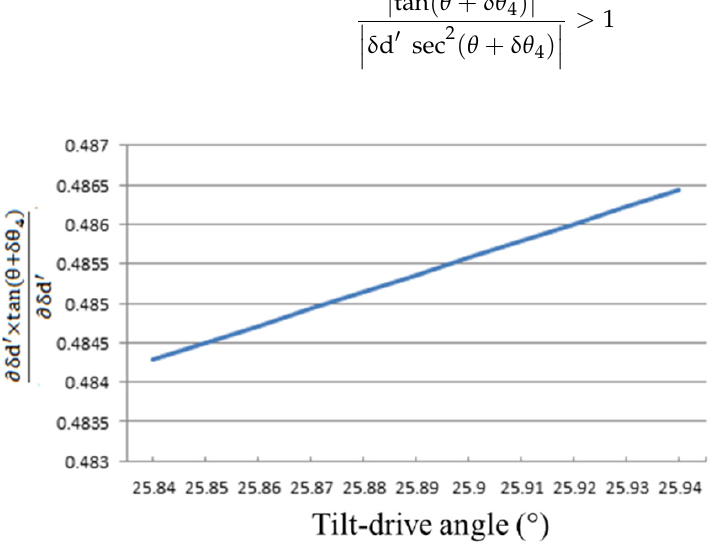
δ ′ d and parameter sensitivity.